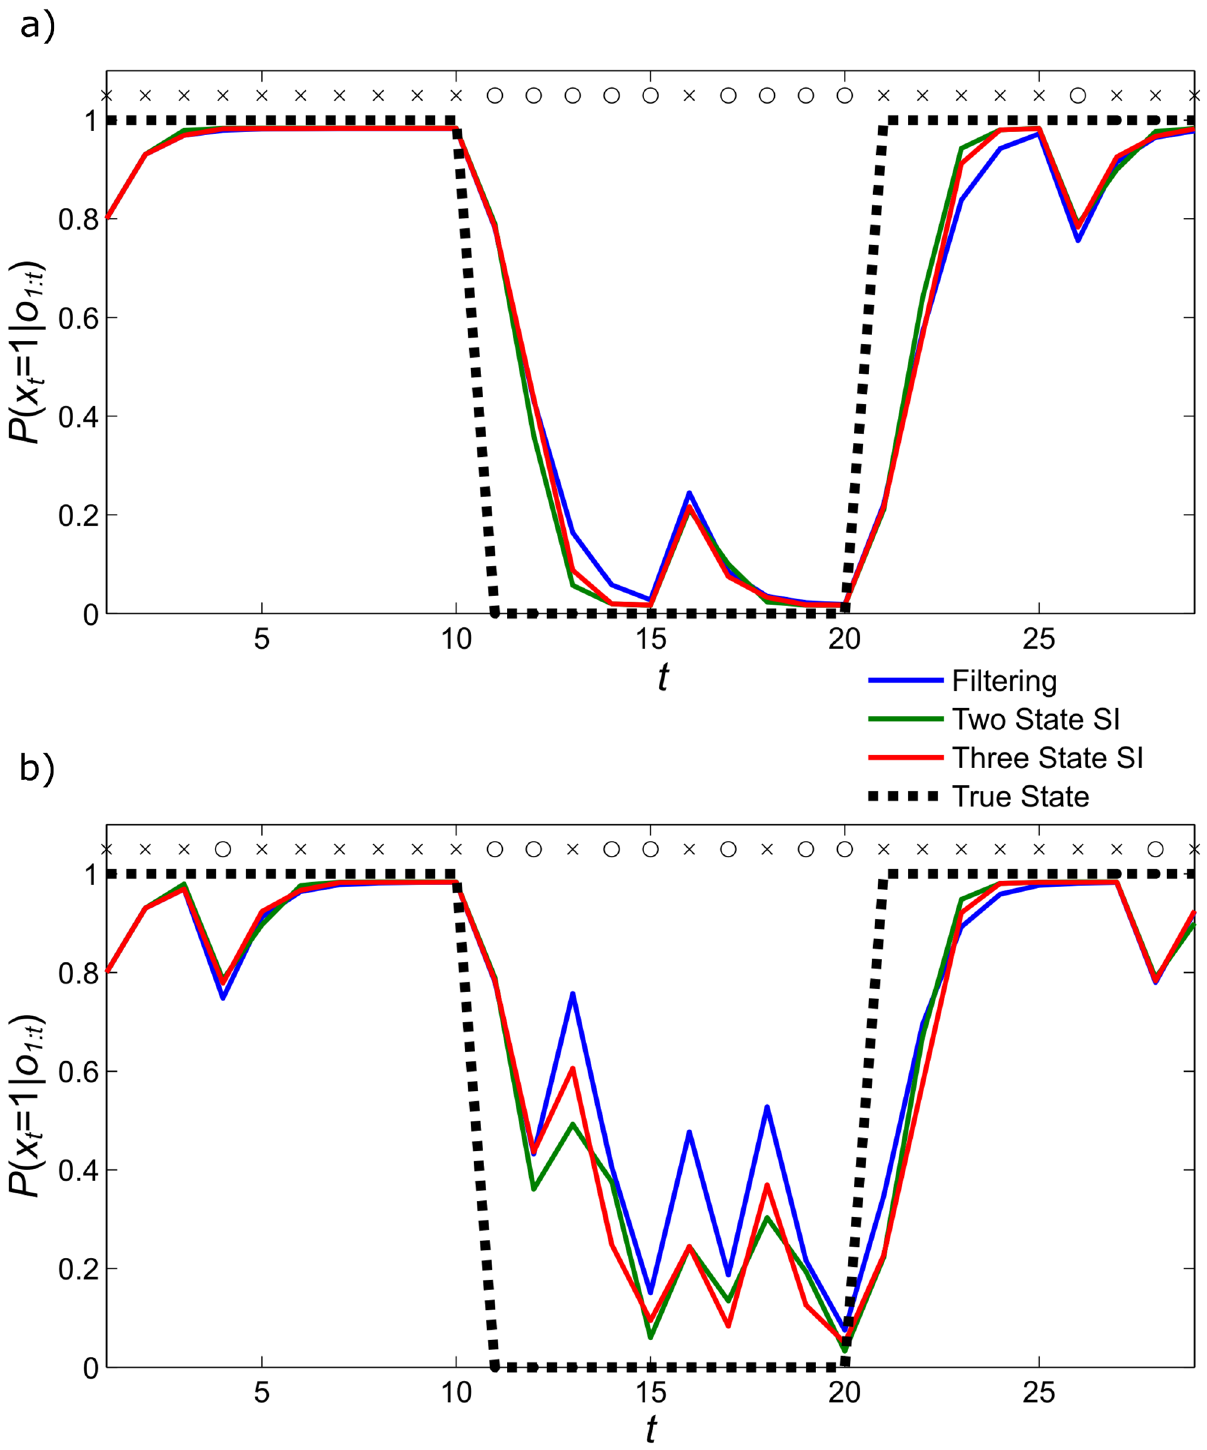
Fig 2. Simulated beliefs for agents employing different sequential inference strategies in performing inference on two different series of observations (Fig. 2a and Fig 2b). Observations on each trial are indicatedby crosses and circles, while the ‘true’ state (i.e., task relevant category) is indicatedby the dotted line. Reversalsoccur when the true state changesvalue (from zero to one, or vice versa) Posterior probabilities for state one obtaining(in other words, the agents’beliefs at the end of each trial) are shown for the filtering model (S1) in blue, for the two state sequential inferencemodel (S2) in green and the three state sequential inferencemodel (S3) in red. In this